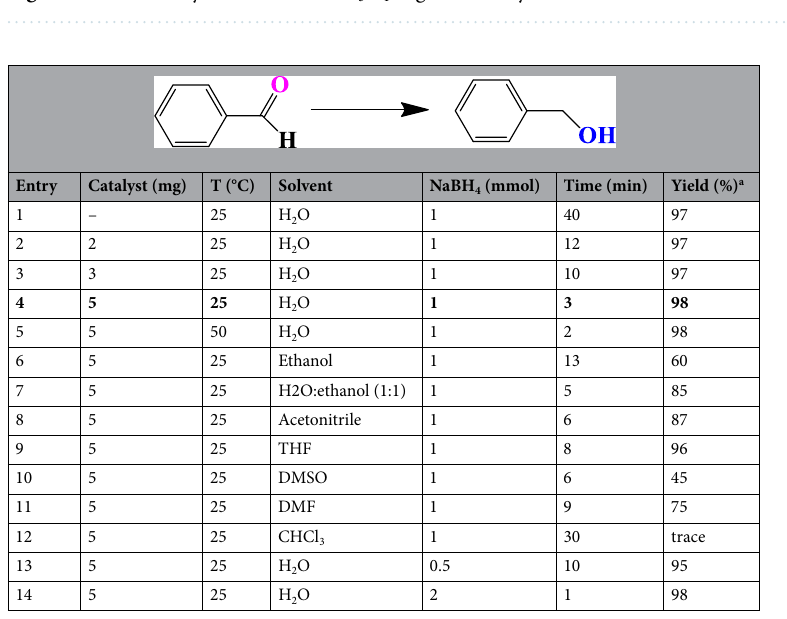
Figure 5. Reusability of the biochar/Fe 3 O 4 –Ag nanocatalyst for the nitroaromatic reduction reaction.